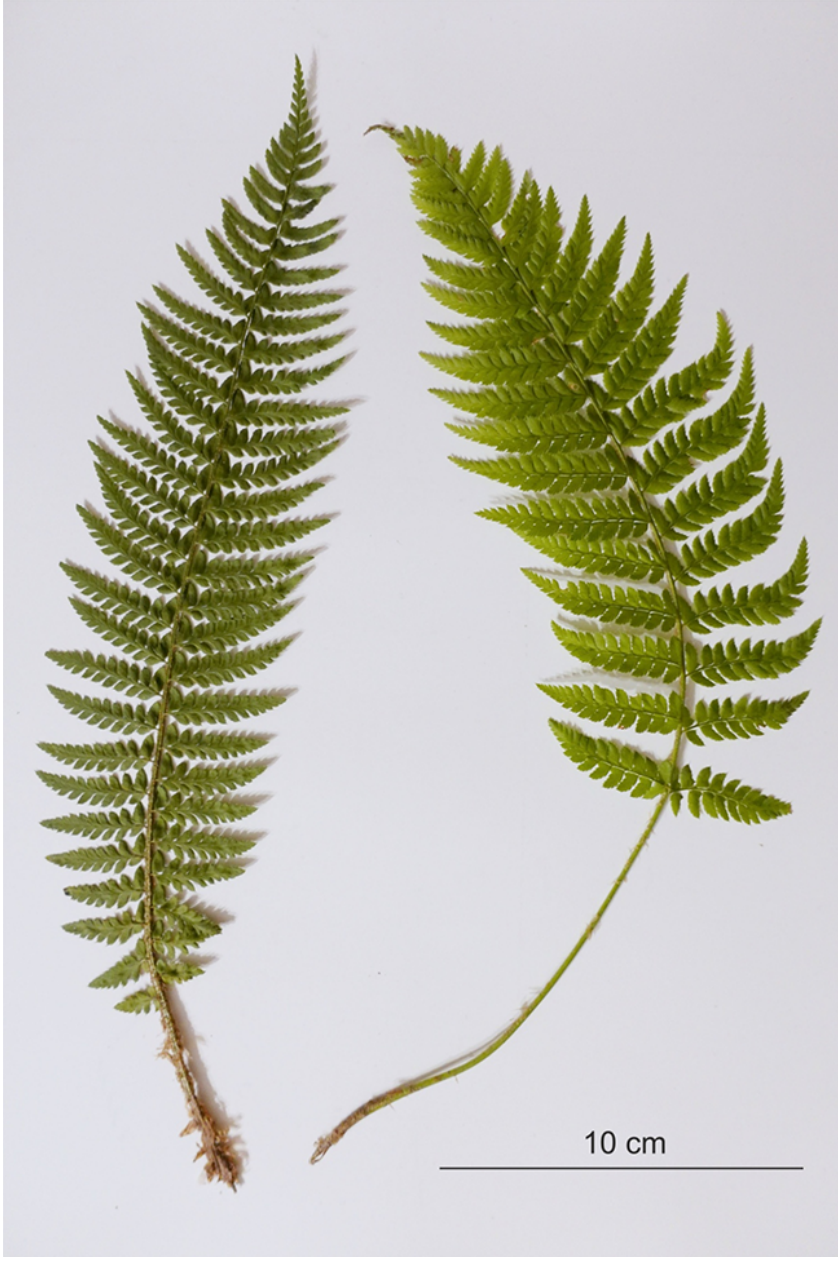
Figure 2 Leaves of Polystichum setiferum (right) from Mt Czupel in the Beskid Śląski and P. aculeatum (le) from the Soła Valley in Kobiernice in the Pogórze Śląskie (Poland) (photo by D. Tlałka, January 8,